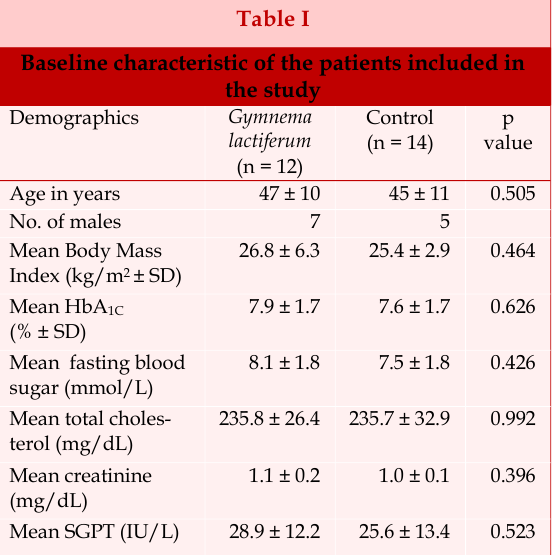
Baseline characteristic of the patients included in the